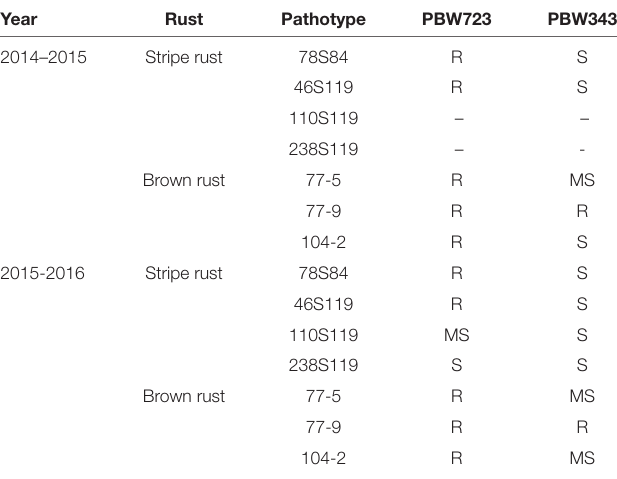
TABLE 7 | Rust reaction of PBW723 at seedling stage against prevalent stripe and brown rust pathotypes.